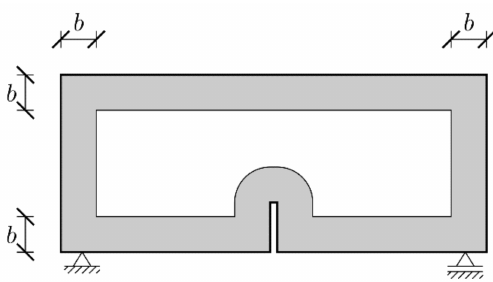
Figure 4. Geometry of the boundary layer